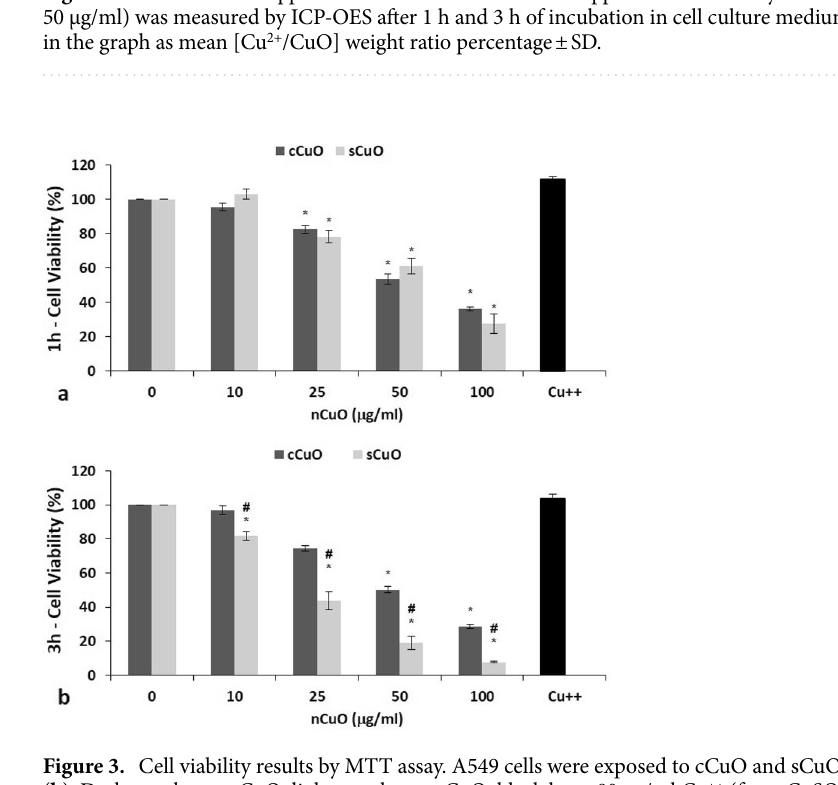
Figure 3. Cell viability results by MTT assay. A549 cells were exposed to cCuO and sCuO for 1 h ( a ) and 3 h ( b ). Dark grey bars = cCuO; light grey bars = sCuO; black bar = 80 µg/ml Cu ++ (from CuSO 4 ·5H 2 O). Results are expressed as mean ± SD. *Significantly different from control (ANOVA + Fisher LSD Method, p < 0,05). # Significantly different from the other experimental group tested at the same concentration (t-test, p =